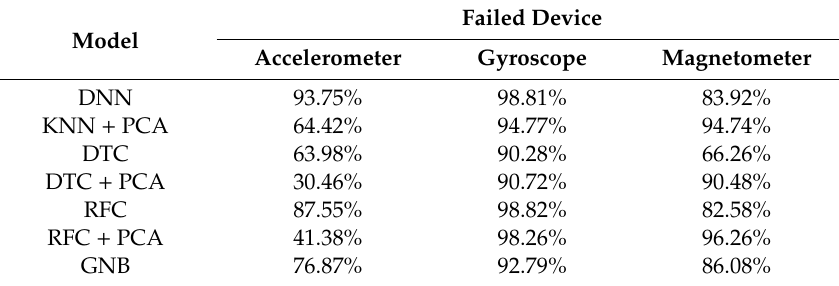
Table 5. Inference accuracy with a device failure in one